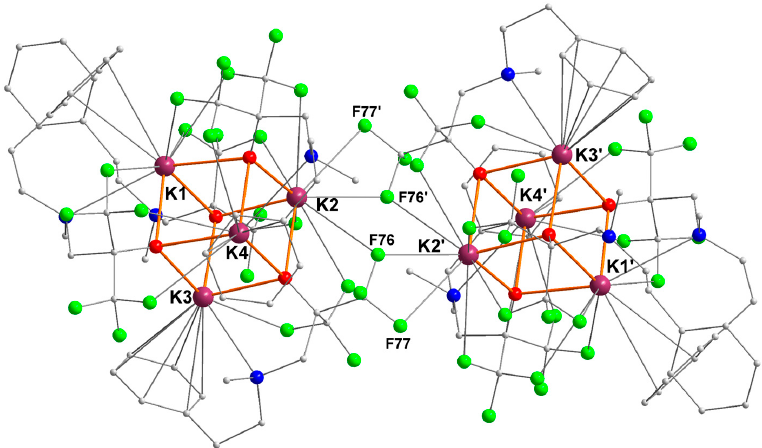
Figure 1. Representation of the molecular solid-state structure of the potassium–arene complex [{RO 1 }K] 4 ([ 1 ] 4 ). Color code: purple, K; green, F; blue, N; red, O; grey, C. H atoms omitted for clarity.